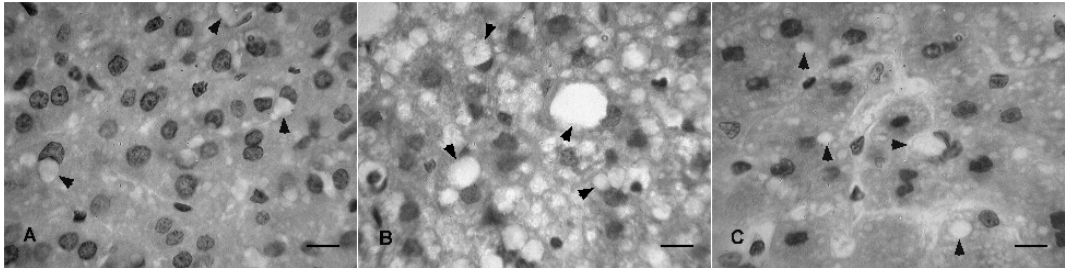
Figure 3. Histological sections of rat’s liver from the experimental groups: GM-CLA ( A ) CO ( B ) and CON ( C ). Arrows indicates fat accumulations on liver cells, characteristic of hepatic steatosis. Scale bar = 10 μ